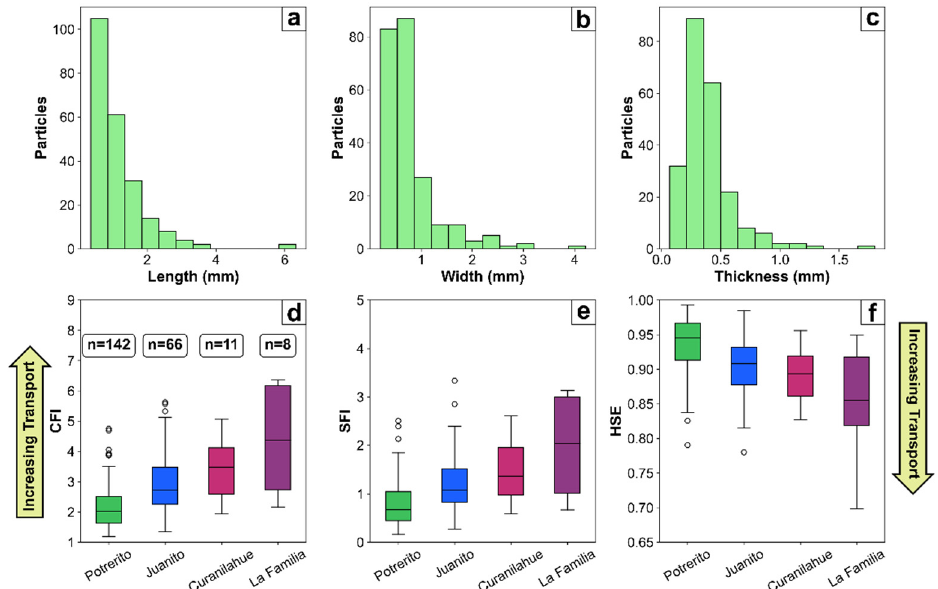
Figure 3. Gold particle size and morphological index values obtained in the Pureo area. ( a – c ) His- tograms of particle dimensions (Length (L), Width (W) and Thickness (T)) for all samples. ( d – f ) Box- plots for morphological index values. Boxes represents inter-quartile range, horizontal line in the boxes represents the median, whiskers extend from the box by 1.5x the inter-quartile range and the white dots represents flier values that are outside the whiskers. CFI: Cailleux’s flatness index, SFI: Shilo’s flatness index. Both CFI and SFI increase with increasing transport; HSE: Hofmann’s shape entropy. HSE decreases with increasing transport.